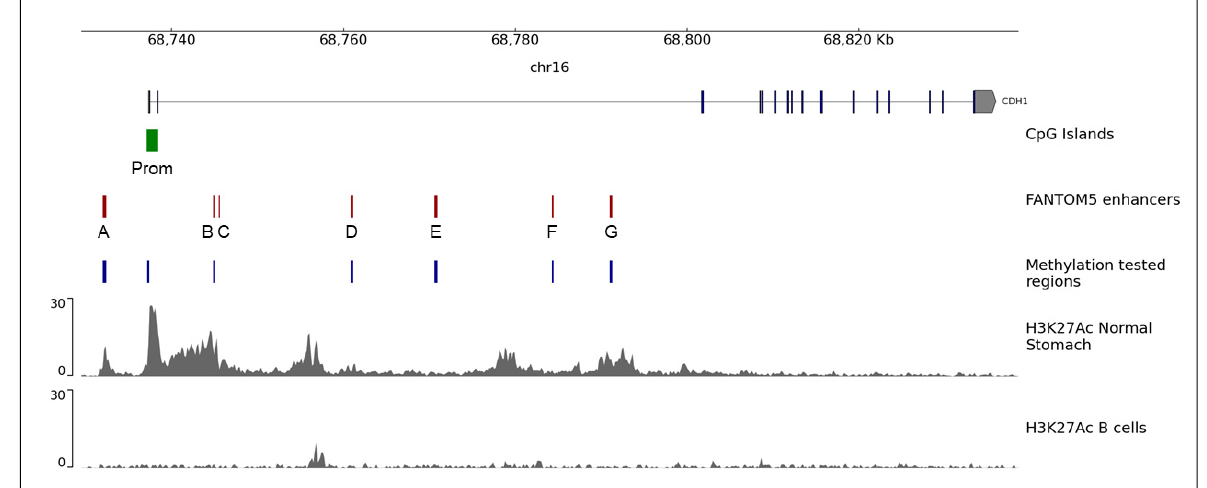
Figure 1. Scheme of the CDH1 gene (chr16) with the CpG island represented by the green bar and enhancers by red bars. Blue bars represent the regions tested for methylation in the present work. The lower panels represent H3K27Ac, a chromatin mark associated with transcription activation [26], in normal stomach and B cells, respectively. The figure was generated with pyGenomeTracks [27].